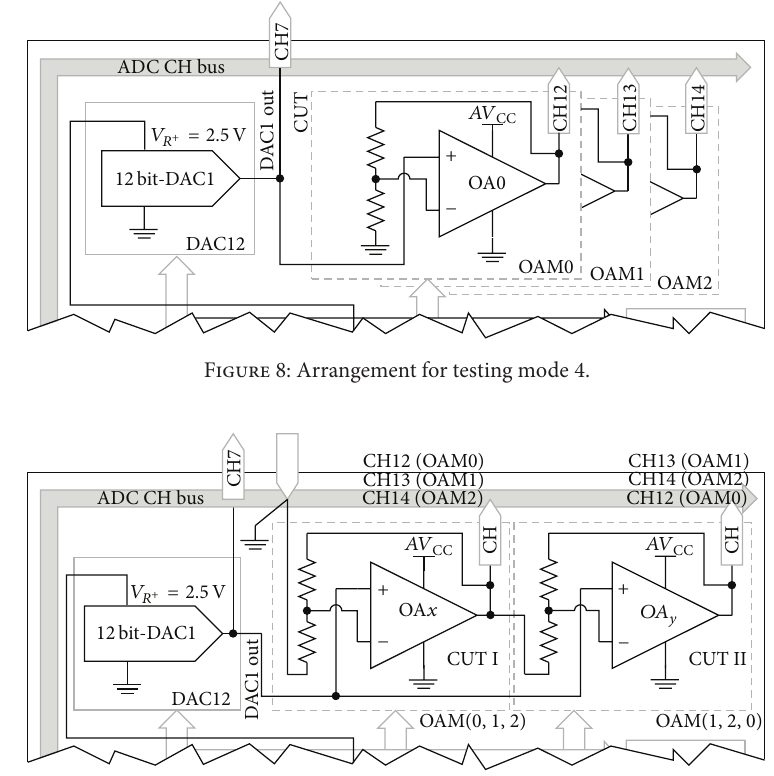
Figure 9: Arrangement for testing mode